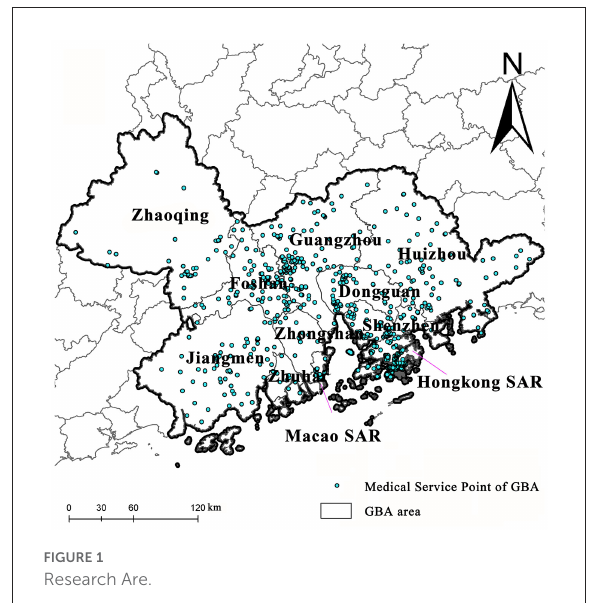
FIGURE1 Research